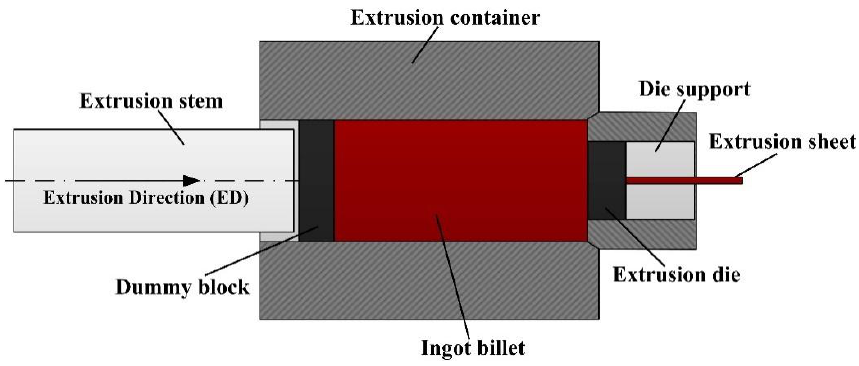
Figure 1. Sketch of the one-step extrusion process for AZ61 alloy.